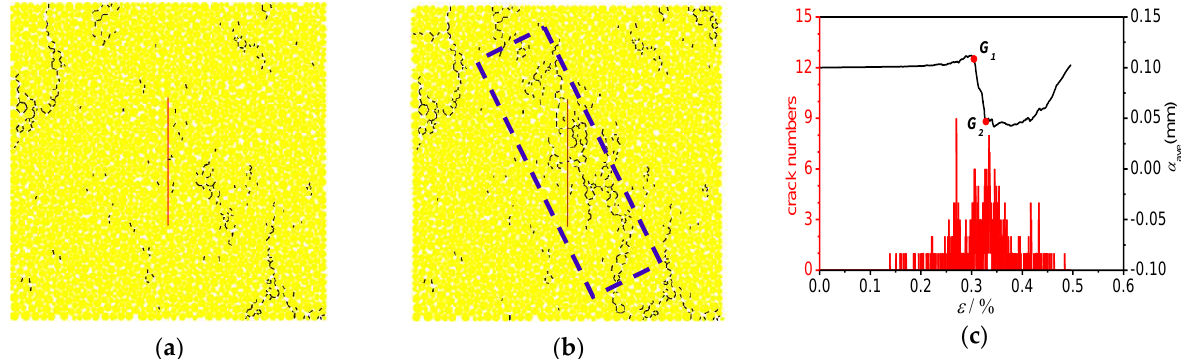
Figure 20. Breakage distribution of contact bonds in the matrix of the specimen with β = 90 ◦ at ( a ) point G 1 and ( b ) point G 2 , and ( c ) the variation trends of α ave and the number of crack elements over axial strain.